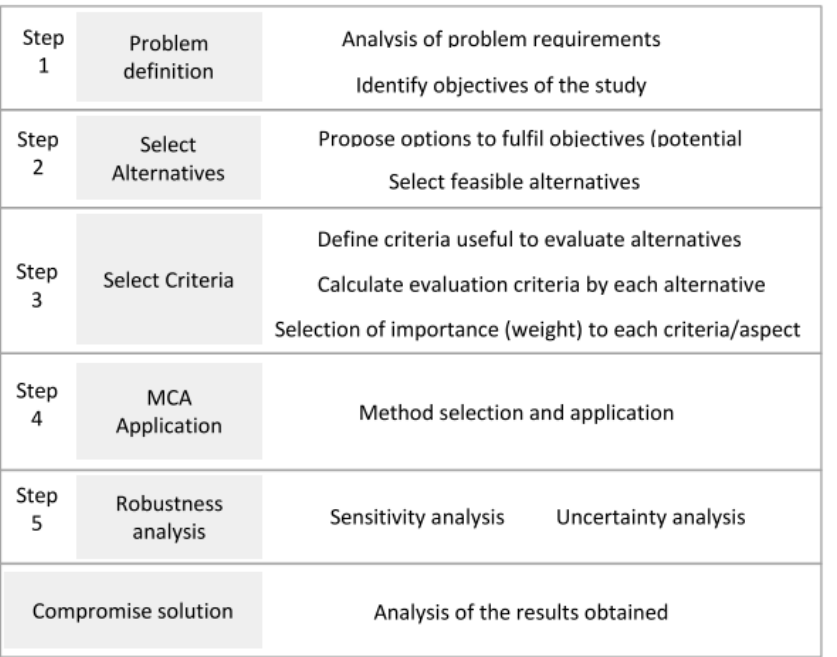
Figure 1. Typical steps included in MCA methodology [23]. Reproduced with permission from Elena Dosal, Doctoral thesis “Towards and improved framework for construction and demolition waste management (C&DW) using decision support tools”, 2015.